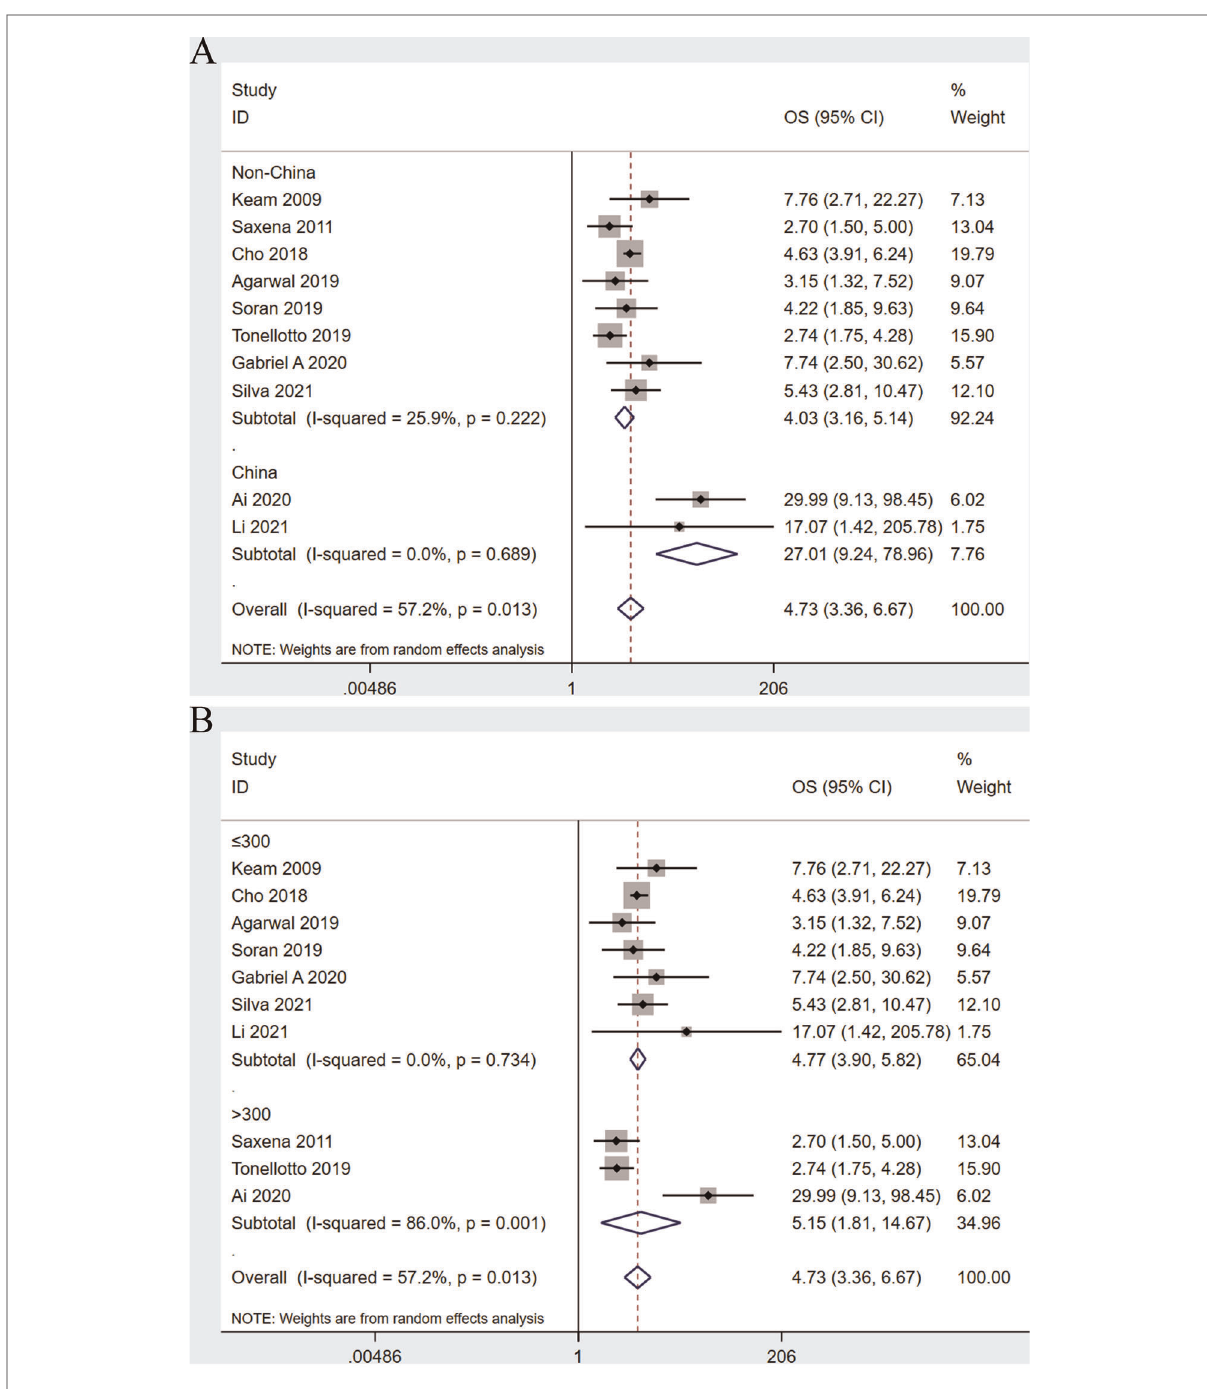
FIGURE 3 Forest plots show the association between lymph node ratio and overall survival strati fi ed by the studied area (A) and sample size